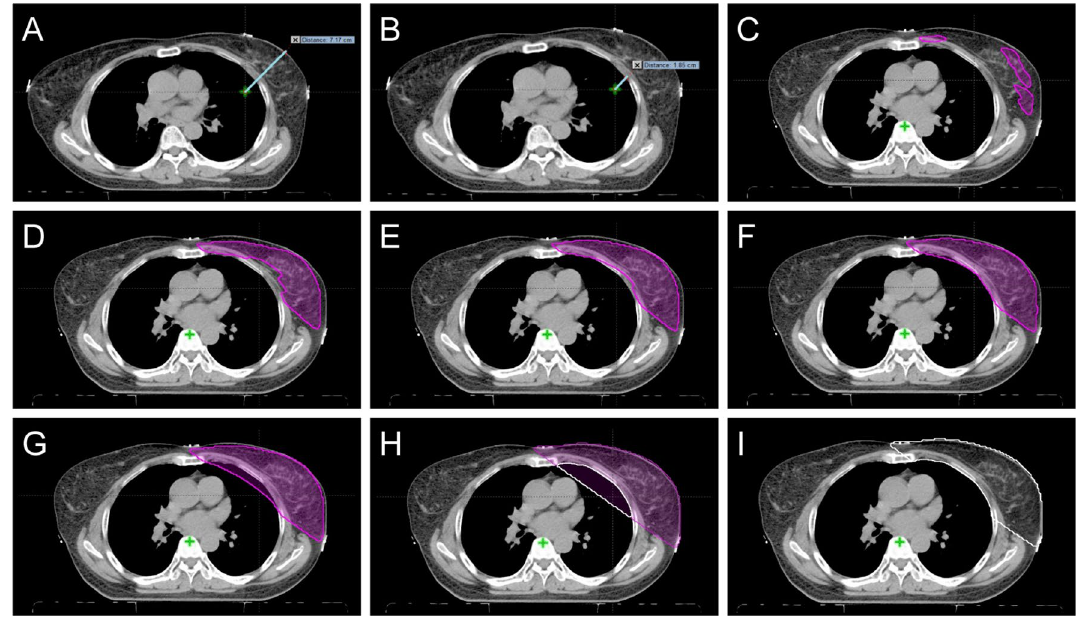
Figure 3. Measurement of clinical and dosimetric parameters. A: Isocenter–Breast axis, B: Isocenter–Lung axis, C: